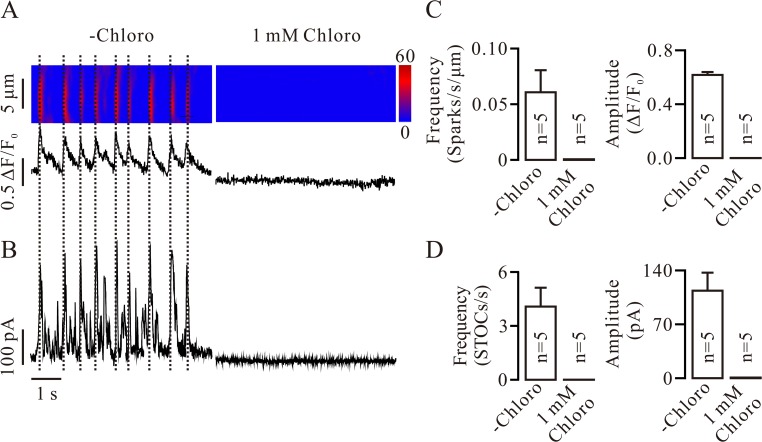
Chloro simultaneously inhibits Ca2+ sparks and STOCs.(A, B) A mouse tracheal smooth muscle cell was patched and held at −40 mV. Ca2+ sparks and STOCs were simultaneously recorded at 0 mV, which were blocked after adding 1 mM chloro. Ca2+ spark-triggered STOCs are indicated by the dashed lines. (C, D) The frequency and amplitude of Ca2+ sparks and STOCs from 5 cells are summarized. These data further demonstrate that the disappearance of STOCs will be due to the blockade of RyRs by chloro.